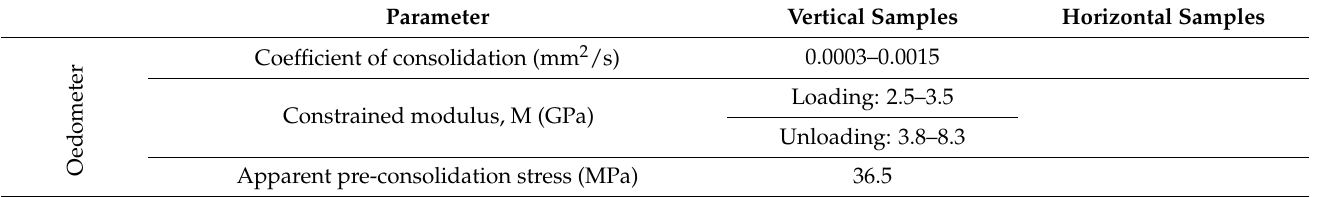
Table 4. The range of values measured from oedometer and triaxial testing of Draupne shale in this study.